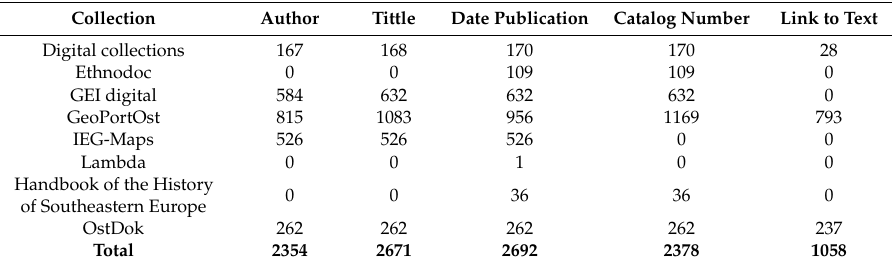
Table 6. Detailed information about source.